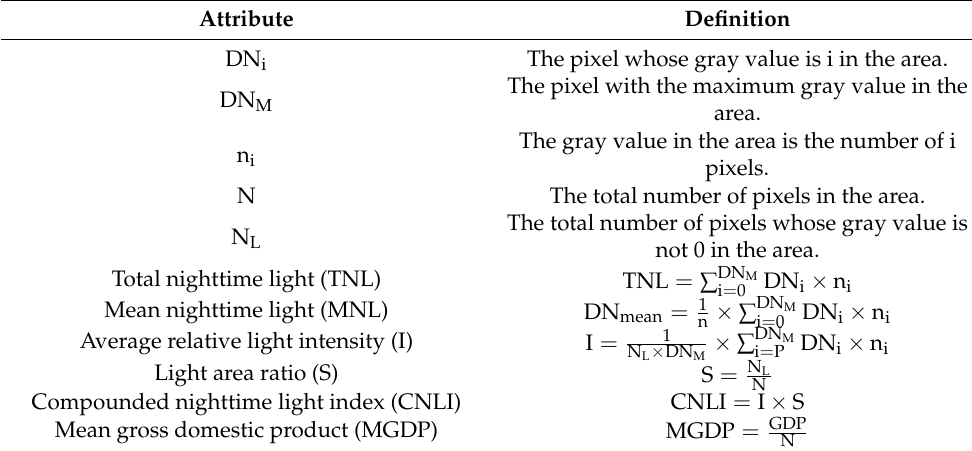
Table 1. NTL indices and economic parameter list.